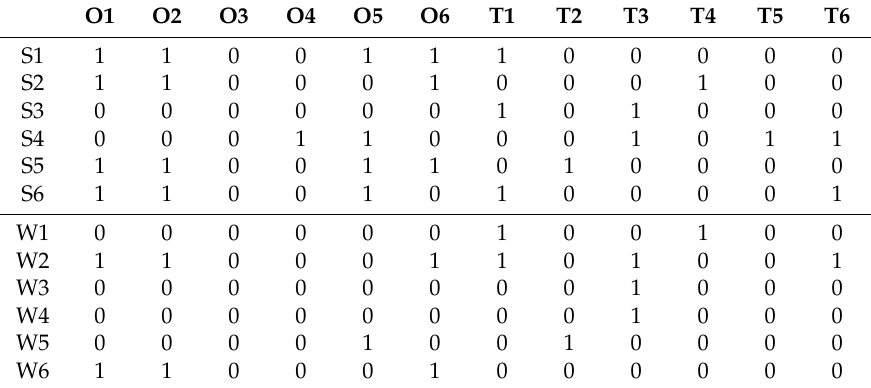
Table 7. SWOT analysis of interrelationships. Source: own study.